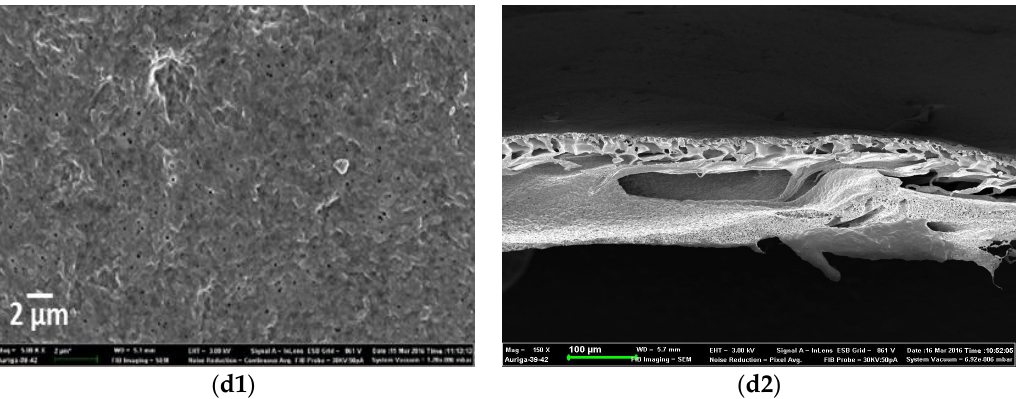
Figure 5. Scanning electron microscopy (SEM) images for top surfaces of ( a1 ) PVDF-HFP, ( b1 ) Ag/PVDF-HFP, ( c1 ) MWCNTs/PVDF-HFP, and ( d1 ) Ag-MWCNTs/PVDF-HFP and their cross-sections ( a2 , b2 , c2 , d2 ). Table 1. Structural features and fouling resistance rate of PVD-HFP and composite